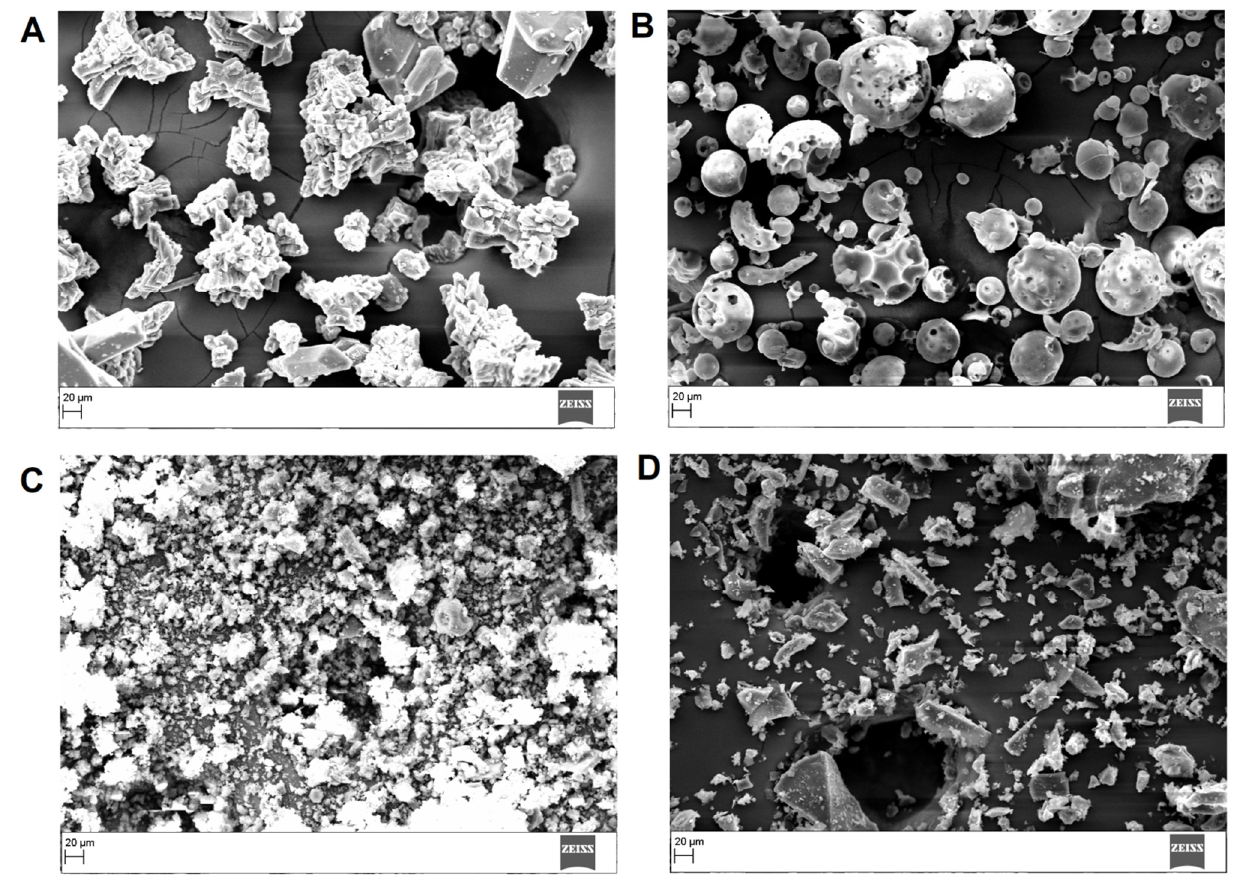
Figure 4. SEM image of ( A ) SA, ( B ) HPβCD, ( C ) BPM, and ( D )